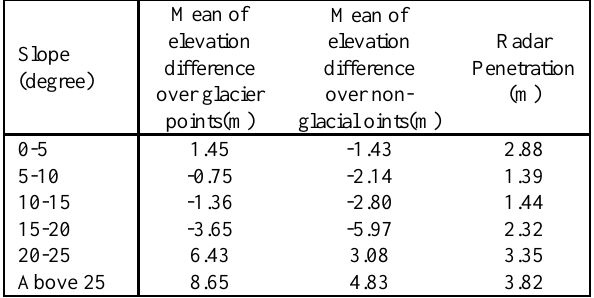
Table 1. Mean of GLAS minus SRTM elevation difference